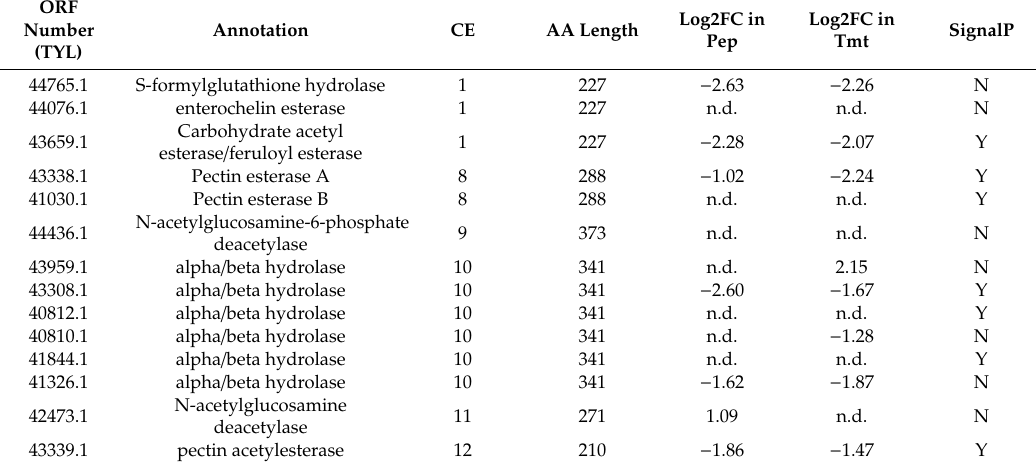
Table 4. Pectin degradation relevant CE enzymes and its transcriptome profile in pepper or tomato stalk compared to LB medium.